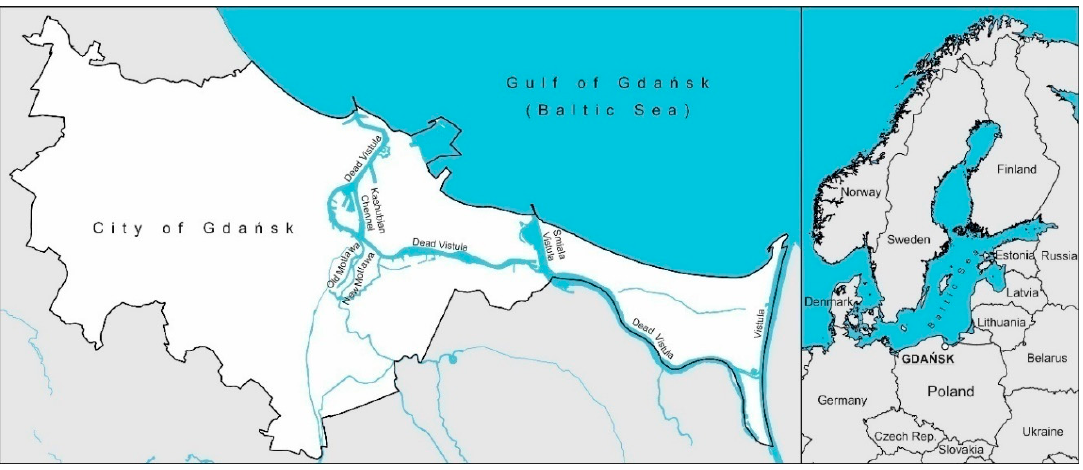
Figure 1. Location of the city of Gdansk.